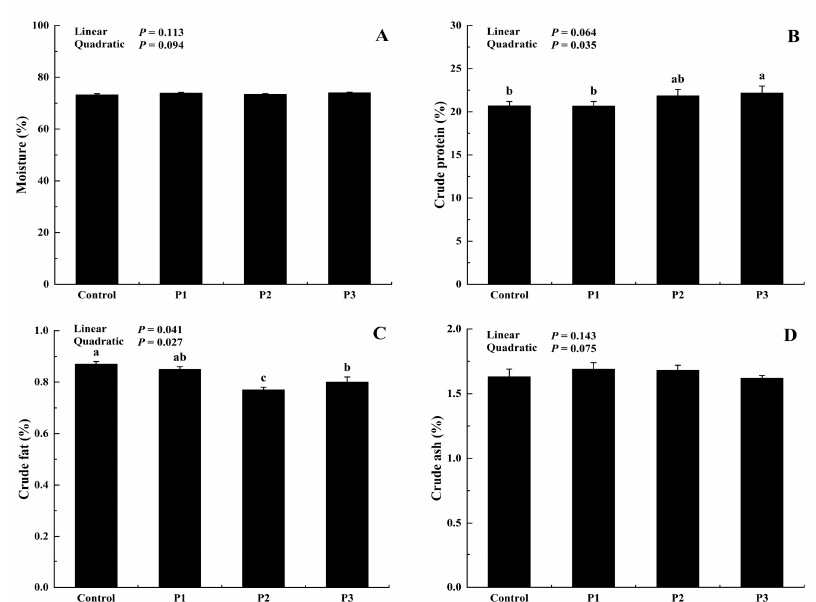
Figure 5. Effect of dietary dried jujube fruit powder (DJFP) supplementation on breast meat composition of broilers. ( A ) Effect of dietary DJFP supplementation on the moisture content of the broilers. ( B ) Effect of dietary DJFP supplementation on the crude protein content of the broilers. ( C ) Effect of dietary DJFP supplementation on the crude fat content of the broilers. ( D ) Effect of dietary DJFP supplementation on the crude ash content of the broilers. Control, P1, P2, and P3 diets contained 0, 50, 100, and 150 g/kg DJFP in the diet, respectively. a–c Values with different letters above the column mean significant difference ( p <